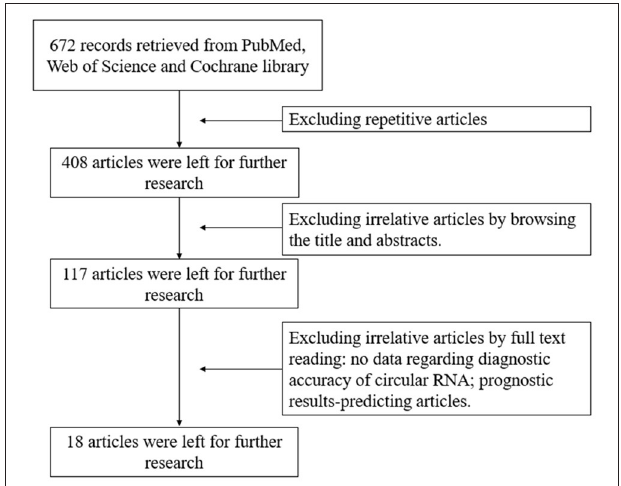
FIGURE 1 | Flowchart of study selection process. The meta-analysis identified 18 eligible studies that used circular RNAs as diagnostic biomarkers for colorectal cancer.